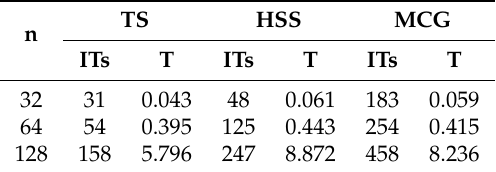
Table 3. Comparison of ITs and T when choosing r = 1.0.